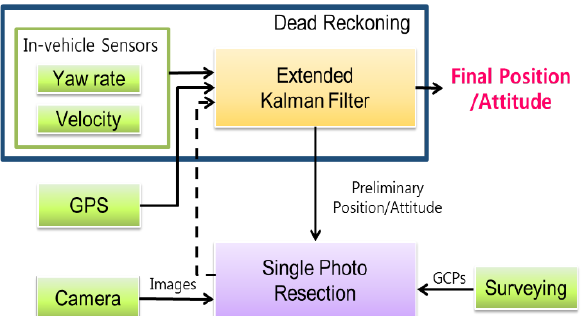
Figure 1. The proposed position and attitude